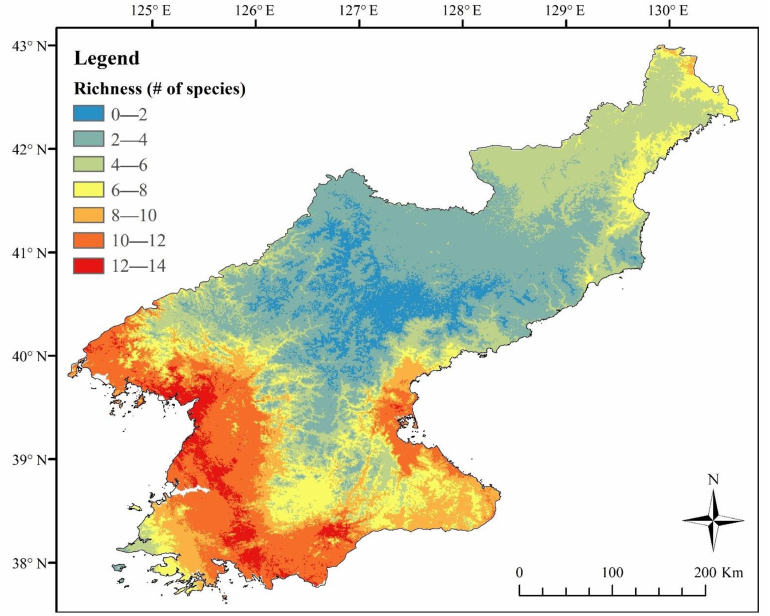
Figure 8. Amphibian species richness for all amphibian species recorded in DPR Korea. This map combines MaxEnt models (Figure 9) using a sum of presence probabilities. Map was created in ArcGIS 10.5 (ESRI; Redlands, CA,